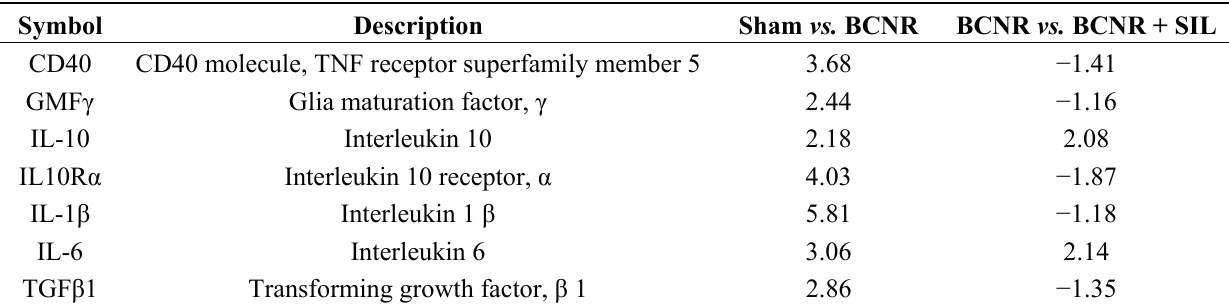
Table 1. Changes in the gene expression profile of cytokines after bilateral cavernosal nerve resection (BCNR) and treatment with Sildenafil (SIL) determined by PCR array.